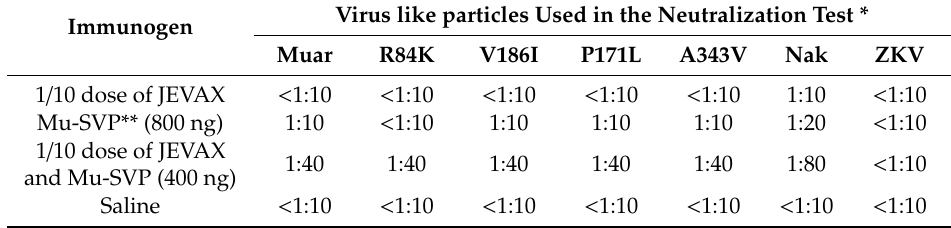
Table 2. Immunogenicity of JEVAX and Mu-SVP. Immunogen